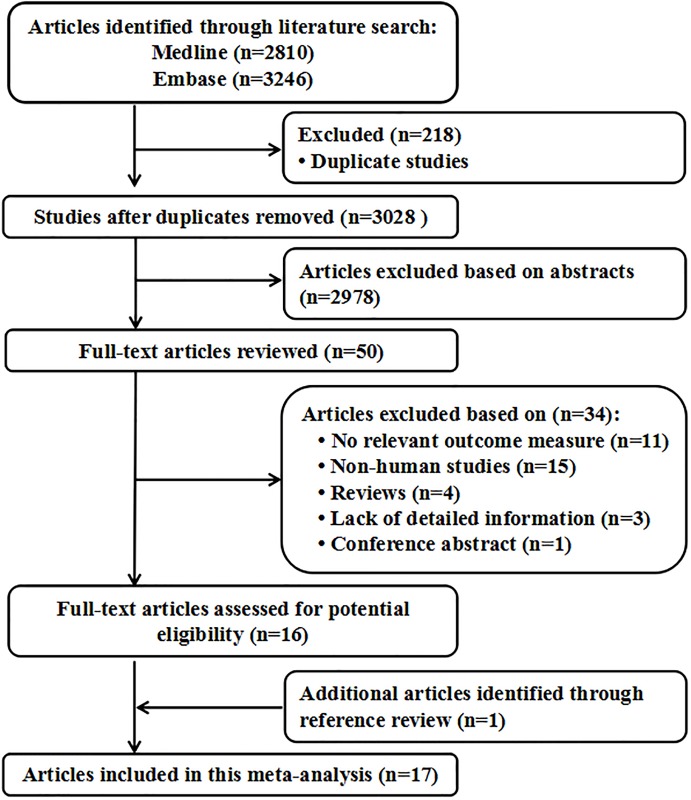
Flow diagram of the study selection process.